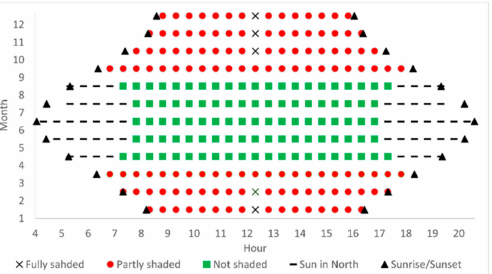
Figure 9. State of shading: north-facing surface, latitude 52.21 ◦ N, D = 20 m, H = 10 m, L = 40 m.